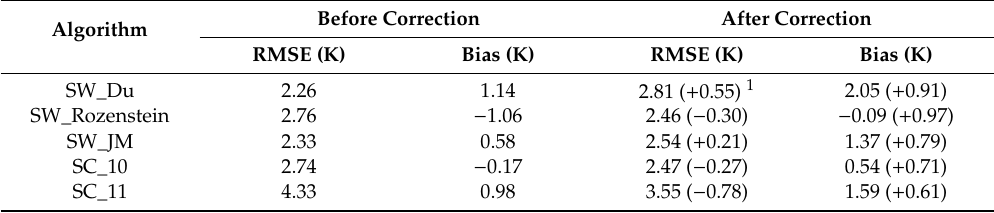
Table 4. The RMSE and bias of Landsat 8 LST retrieval from five algorithms before and after the stray light correction over all five